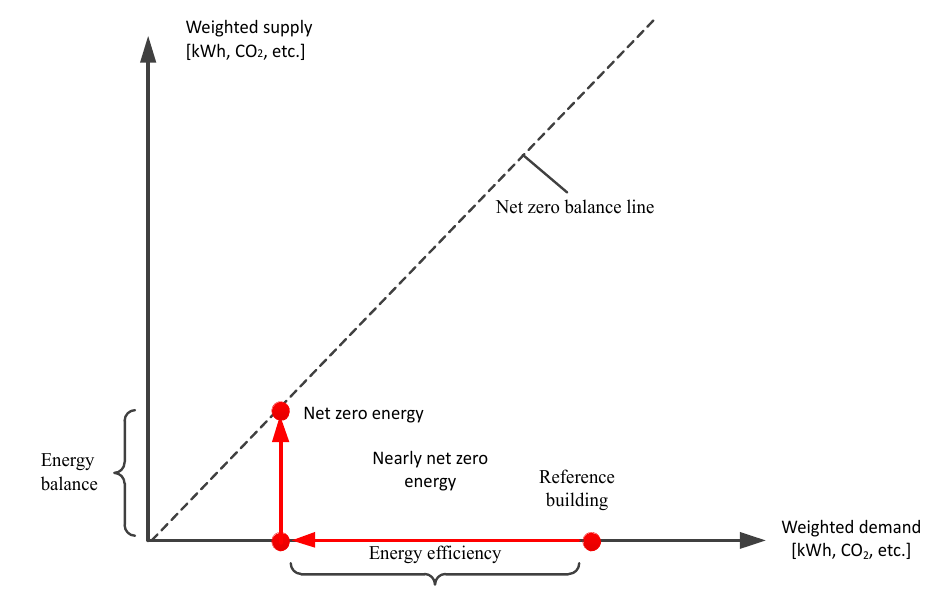
Figure 1. Graphical representation of nearly zero energy building (nZEB) balance